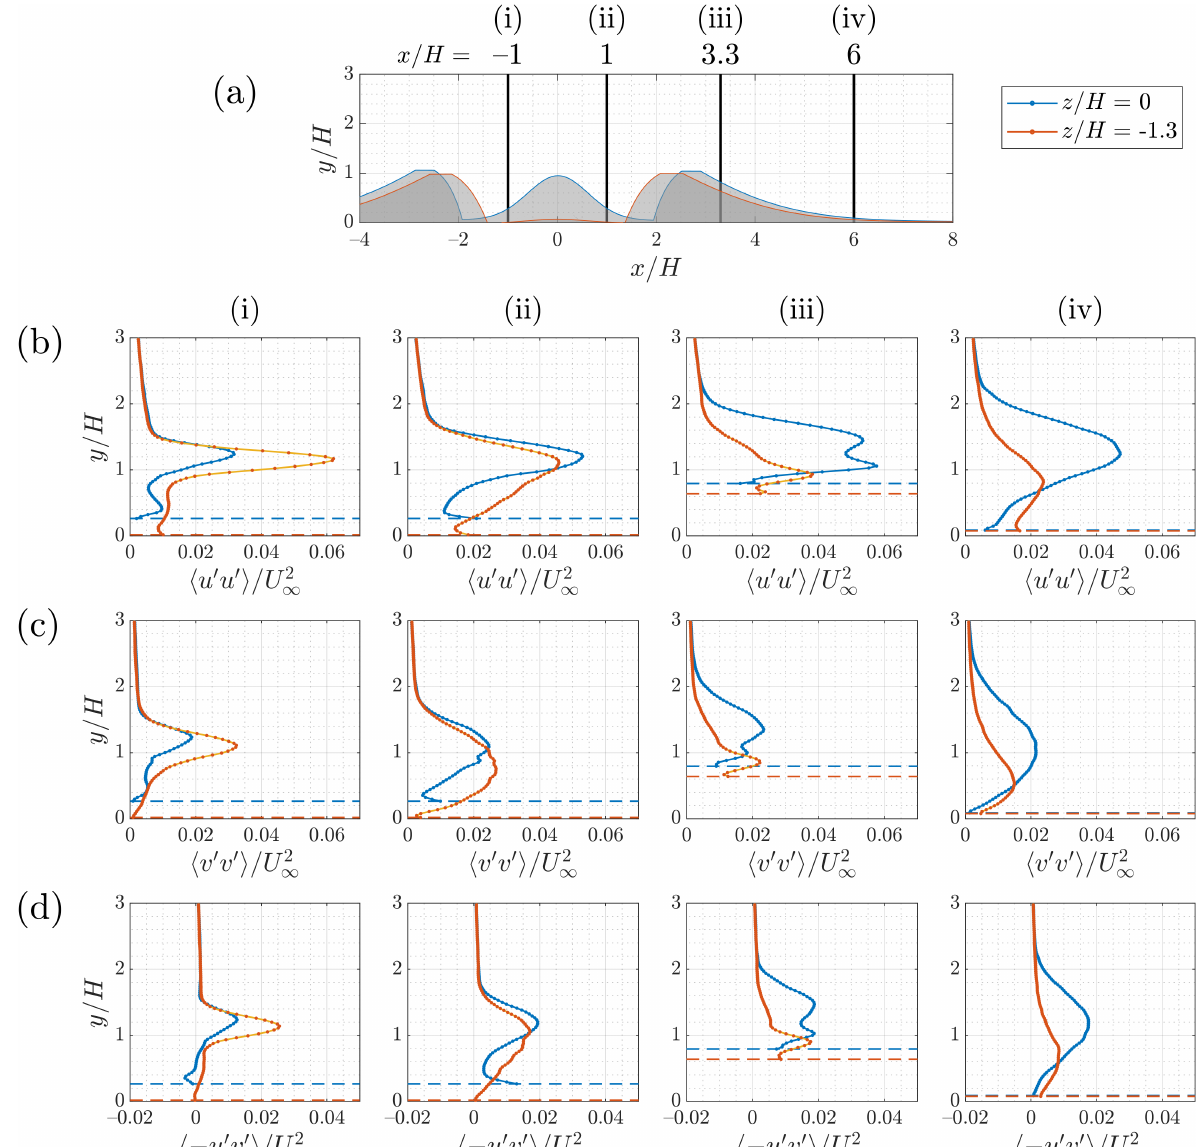
Figure 12. ( a ) A schematic of the crater rim profile at the two spanwise locations showing the reference of the stream- wise positions of the profiles. (blue) Centerline plane, z / H = 0; (red) offset plane, z / H = 1.3. (b-d) Vertical pro- files of Reynolds stresses normalized by U 2 ∞ at the streamwise locations at x / H = ( i ) − 1, ( ii ) 1, ( iii ) 3.3, and ( iv ) 6. ( b ) (cid:104) u (cid:48) u (cid:48) (cid:105) / U 2 ∞ , ( c ) (cid:104) v (cid:48) v (cid:48) (cid:105) / U 2 ∞ , and ( d ) (cid:104)− u (cid:48) v (cid:48) (cid:105) / U 2 ∞ . The dashed lines in ( b – d ) demarcate the locations of the model’s surface. Re H = 8.9 × 10 3